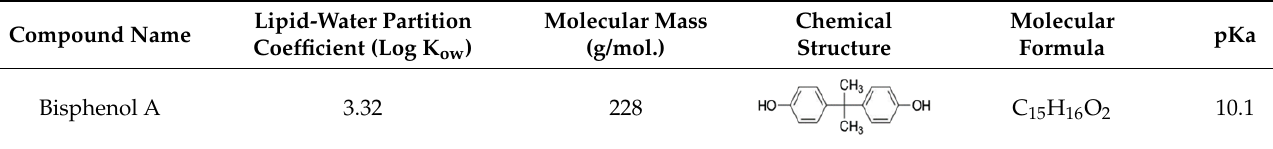
Table 1. Properties of Bisphenol A (BPA).